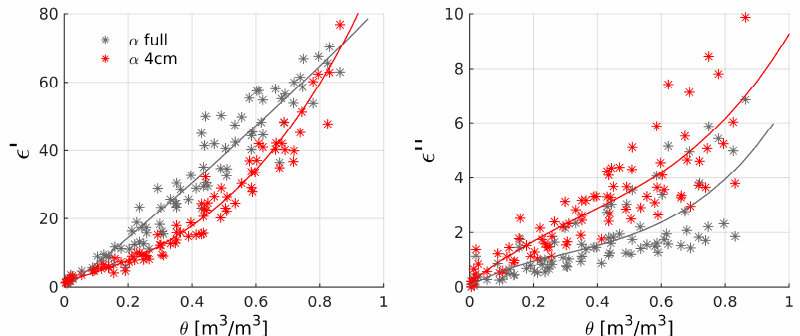
wetness range and filtered as specified in Section 2.2.3, in grey when using an alpha filling factor for the full tube length and in red specifically calibrated for the 4 cm tube insertion depth. colors for individual (a) mineral and (b) organic samples (shades of blue and yellow-red-purple, respectively, see Table 1). The simple empirical models (3rd order polynomials) fit through the cavity datasets obtained from mineral and organic samples are plotted along in Figure 4a,b, respectively (blue and red lines). The corresponding model coefficients are listed in Table 3. Respective statistics are provided in Table 4.